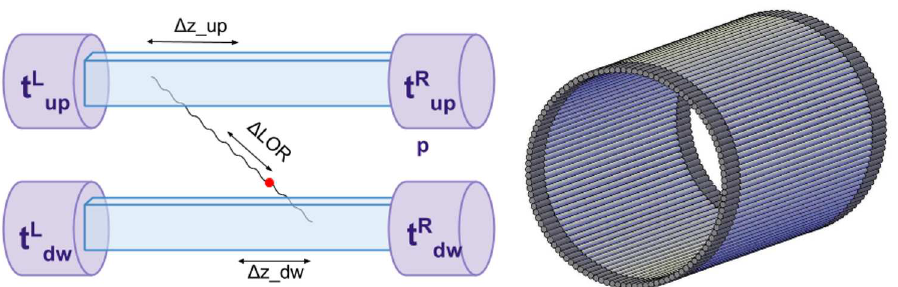
Fig 1. J-PET detection modules: A pair and a single layer. (A) Left panel: scheme of the pair of J-PET detectionmodules.Such pair constitutes a simplest detectionunit capableof registrationboth collinearly propagatingquantaresultingfrom electron—positron annihilation. Times of light signalsarrivals to photomultipliers are denotedas: t L —to left upper photomultiplier, t R —to right upper photomultiplier, t L —to up up dw left lower photomultiplier, t R —to right lower photomultiplier. Red dot indicatesa place of annihilation, Δ z dw denotesthe distancebetweenthe point of interactionin scintillatorand the center of the strip, Δ LOR denotes the positionof annihilationalong the line-of-response betweentwo strips with respect to the centre of LOR. Both Δ z and Δ LOR are determined based on the measuredtimes t R , t L , t L , t R . (B) Right panel:schematic up up dw dw visualizationof an exampleof a single detectionlayer of the J-PET detector. Each scintillator strip is aligned axiallyand read out at two ends by